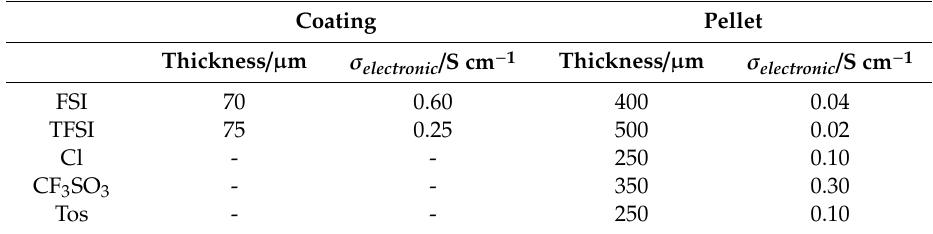
Table 3. Electronic conductivity ( σ electronic ) of coatings and pellets of the PEDOT:PolyDADMA X samples with varying